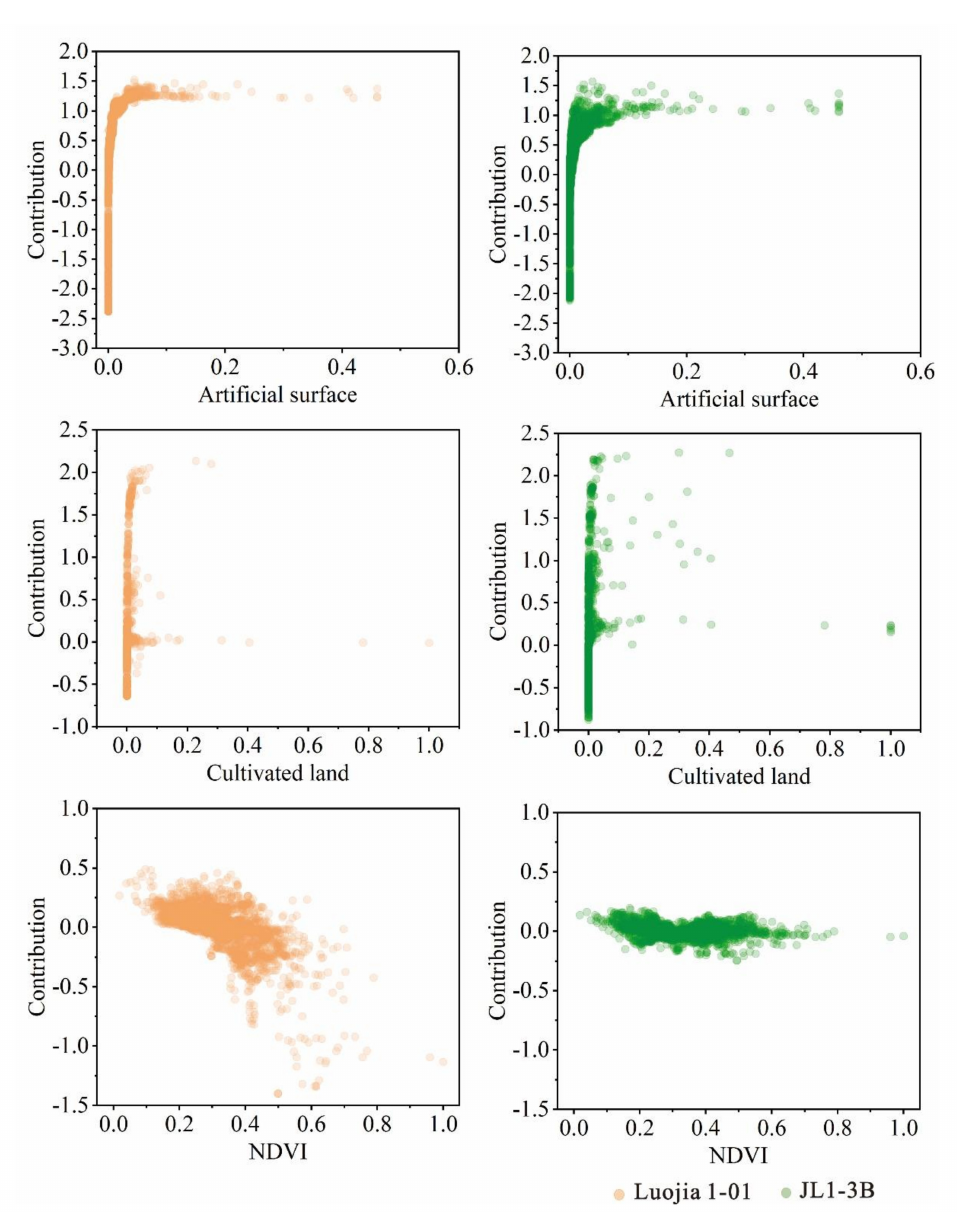
Figure 8. The features contributions of artificial surface, cultivated land, and NDVI in the RF models for Luojia1-01 and JL1-3B